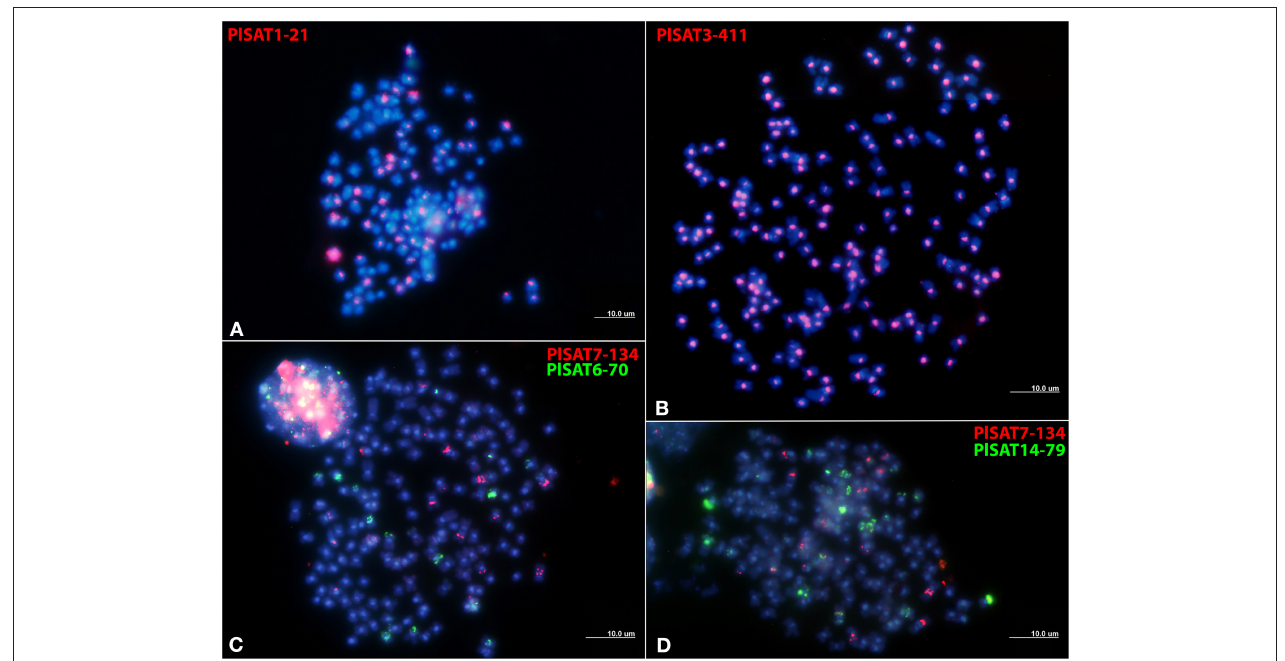
FIGURE 4 | Distribution of satellite repeat families on metaphase chromosomes of Pontastacus leptodactylus . (A) PlSAT1-21 (in red), (B) PlSAT3-411 (in red), (C) PlSAT7-134 (in red) and PlSAT6-70 (in green), and (D) PlSAT7-134 (in red) and PlSAT6-70 (in green) as probes. Chromosomes are counterstained with DAPI. Scale bar = 10 µ